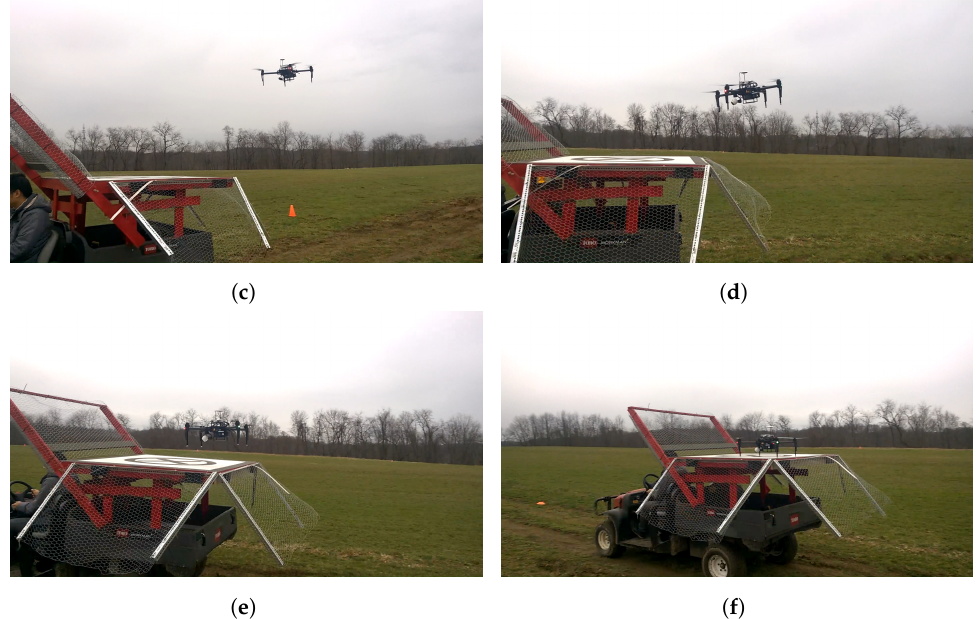
Figure 10. ( a – f ) Screenshots from a video sequence showing our quadrotor landing on the moving vehicle at 15 km/h (4.17 m/s) speed. The video is available on our